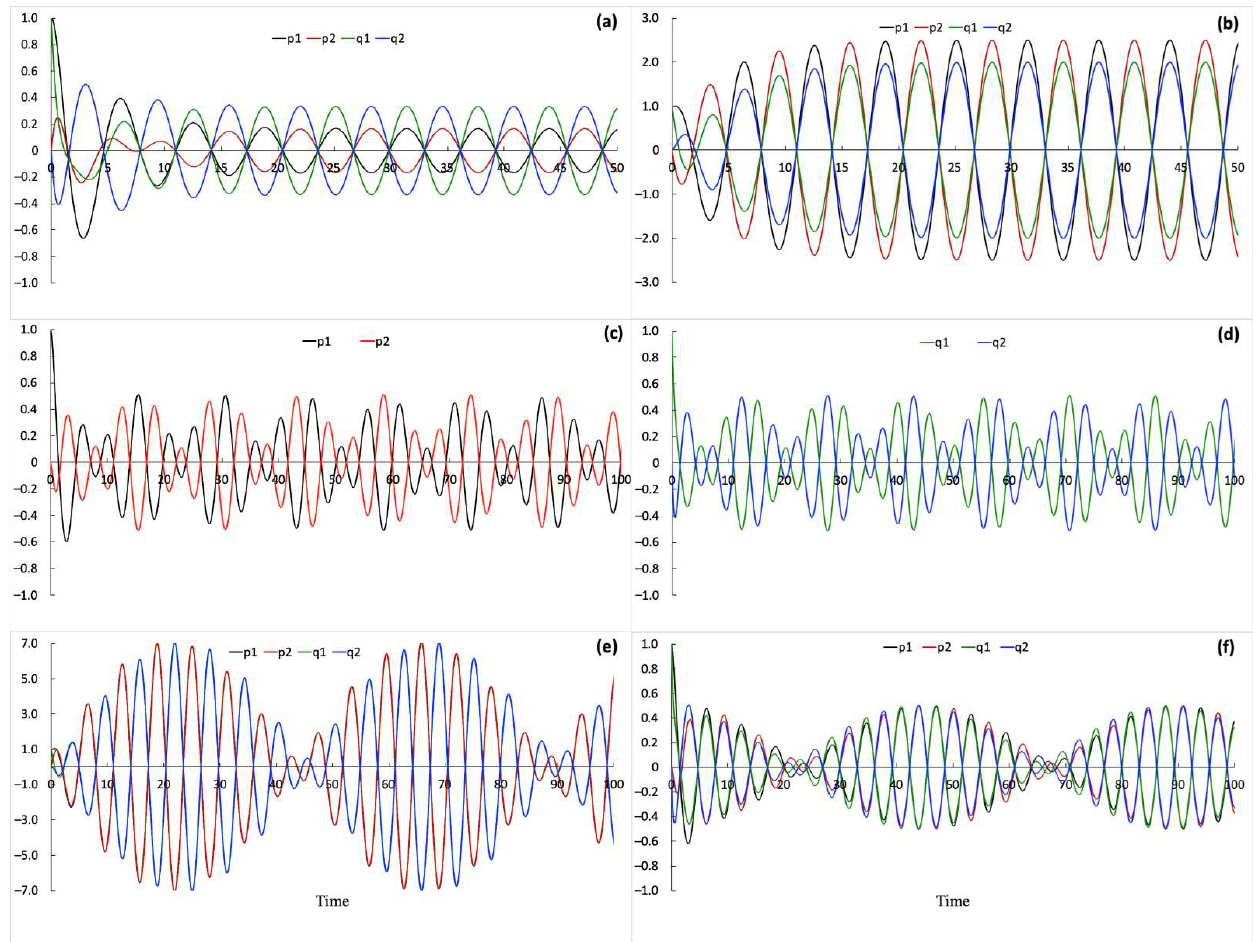
Figure 3. Oscillatory behavior observed in the dynamic system of coupled processes. Oscillations of ( 𝑝 (cid:2869) , 𝑝 (cid:2870) ) and ( 𝑞 (cid:2869) , 𝑞 (cid:2870) ) processes are obtained using the following parameter values: ( a ) ε = 1, α = −1.5; ( b ) ε = −1.8, α = 0.25; ( c , d ) ε = −0.1, α = −1.9, where the ( 𝑝 (cid:2869) , 𝑝 (cid:2870) ) and ( 𝑞 (cid:2869) , 𝑞 (cid:2870) ) processes are shown on separate figure panels for better visualization; ( e ) ε = 1.99, α = 0.01, note that shortly after the starting values the ( 𝑝 (cid:2869) , 𝑝 (cid:2870) ) and ( 𝑞 (cid:2869) , 𝑞 (cid:2870) ) processes begin and continue to overlap over time; ( f ) ε = −0.01, α = −1.99. All simulations are obtained using the same initial conditions: ( 𝑝 (cid:2869) , 𝑝 (cid:2870) , 𝑞 (cid:2869) , 𝑞 (cid:2870) ) = (1, 0, 1, 0) that corresponds to case (i) in Figure 2, and ( 𝑥 (cid:2869) , 𝑥 (cid:2870) , 𝑦 (cid:2869) , 𝑦 (cid:2870) ) = (0, 0, 0, 0).